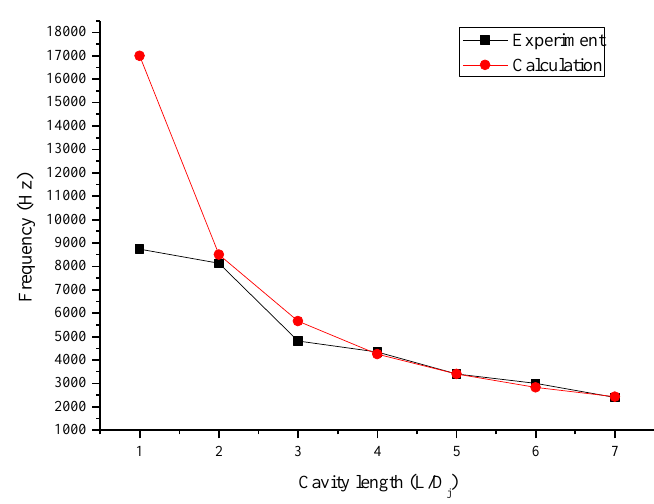
Figure 6. Comparison of the frequency obtained by experiment and calculation.